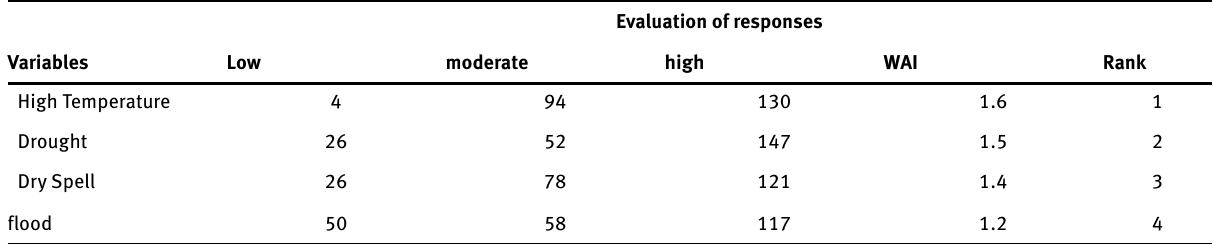
Table 3 : Weather Extremes in the study area.